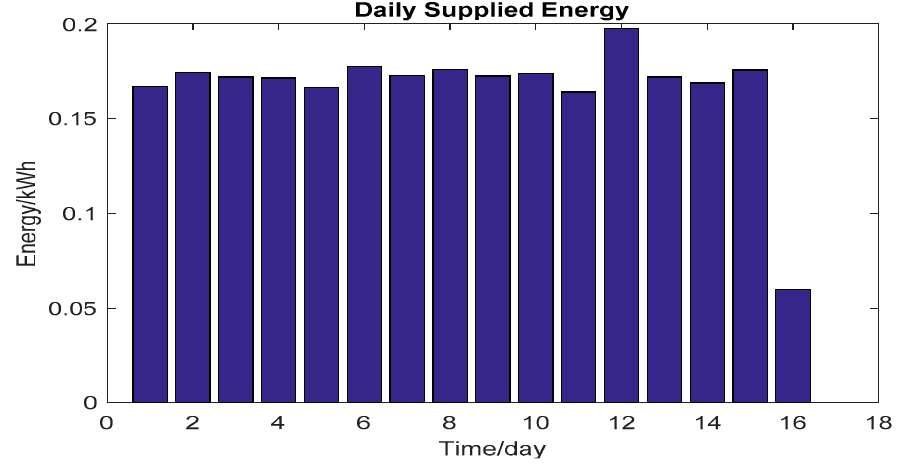
Figure 23. Output power and efficiency of maximum power point tracker (MPPT).